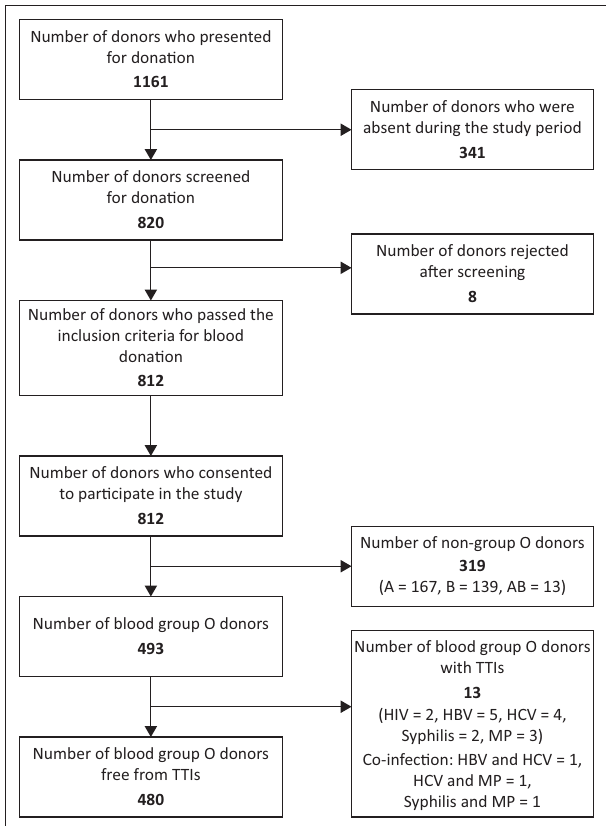
FIGURE 1: Selection of study participants among blood group O donors at the RHBBB, Cameroon, June 2020 – September